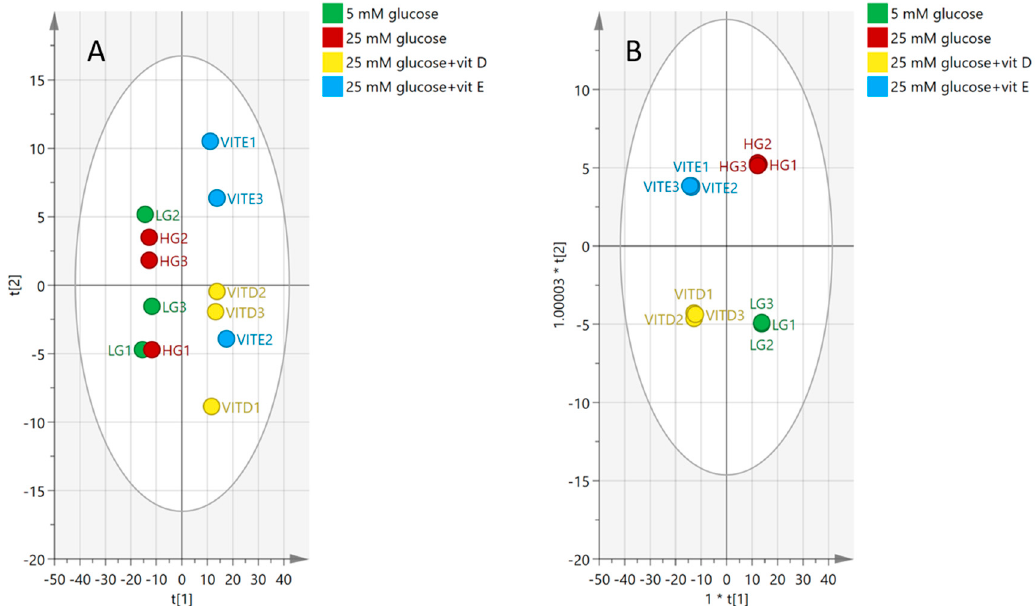
Figure 7. ( A ) Principal components analysis (PCA) plot, ( B ) Orthogonal Projections to Latent Structures Discriminant Analysis (OPLS-DA) plot for groups of normal glucose (five mM glucose), high glucose (25 mM glucose), vitamin D, and vitamin E. The plot shows the distribution of 12 samples based on the reading of 549 putative metabolites.